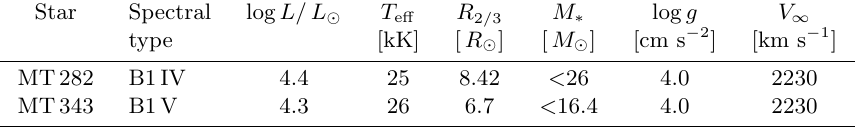
Table 2. Physical parameters of MT 282 and MT 343 estimated using CMFGEN.